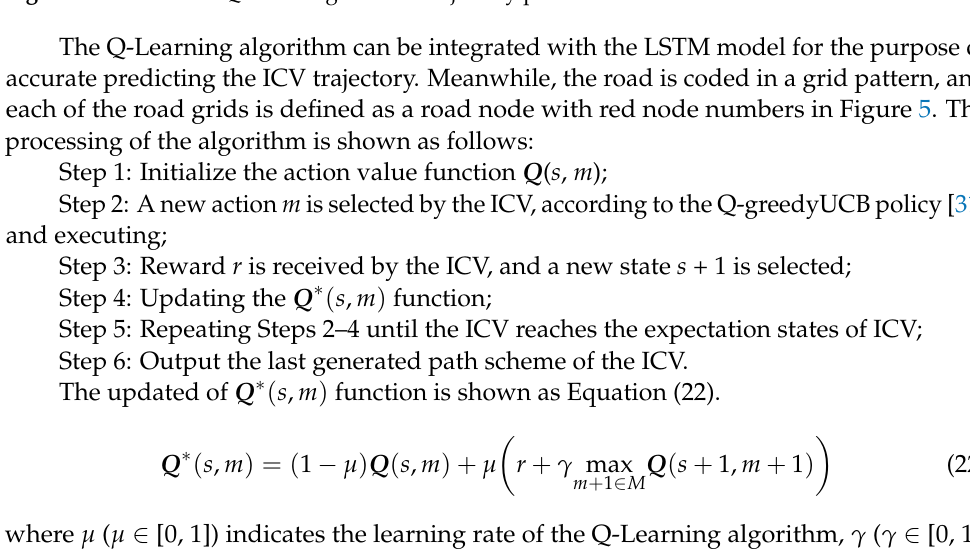
where µ ( µ ∈ [0, 1]) indicates the learning rate of the Q-Learning algorithm, γ ( γ ∈ [0, 1]) indicates the discount factor, which can make the algorithm pay more attention to the current or future reward, Q ( s , m ) indicates the current reward under the current state for the current action, Q ∗ ( s , m ) indicates the desired maximum reward obtained by the ICVs. Generally, the ICVs may have five actions (straight ahead, left lane change, right lane change, left turn, and right turn) at an intersection, as shown in Figure